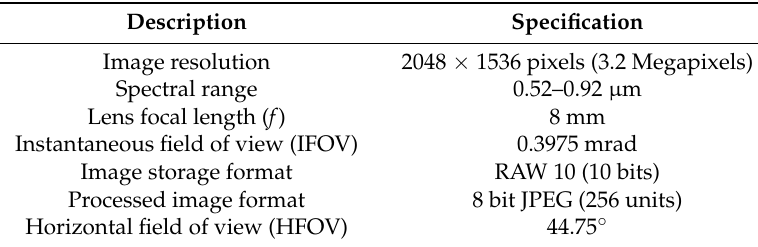
Table 1. Tetracam ADC multispectral camera specifications 1